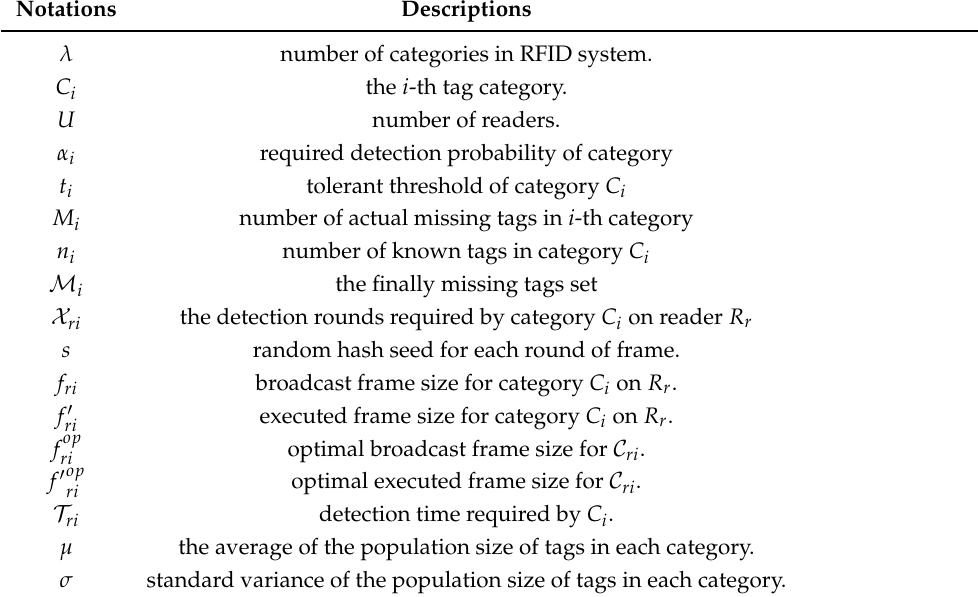
Table 1. Main notations used in the